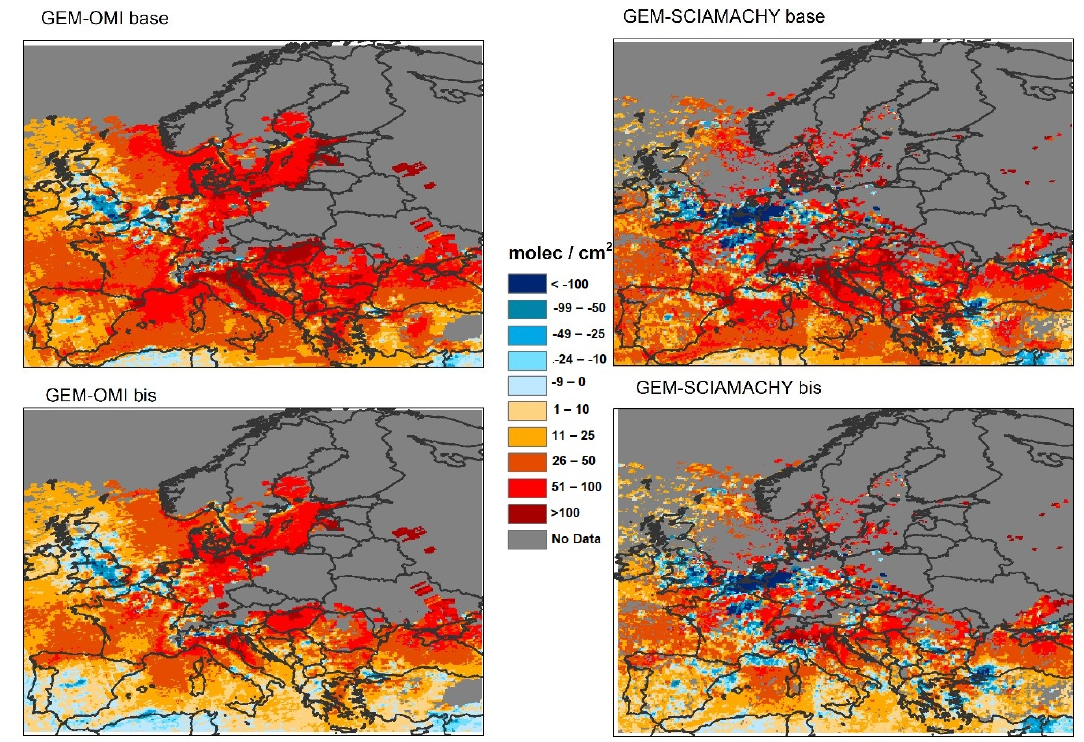
Figure 6. Differences (10 15 molec/cm 2 ) in the tropospheric NO 2 columns derived from GEM-AQ for the baseline emissions (upper row) and the modified emissions (bottom row) and satellite observations (OMI left, right SCIAMACHY) for January 2011.